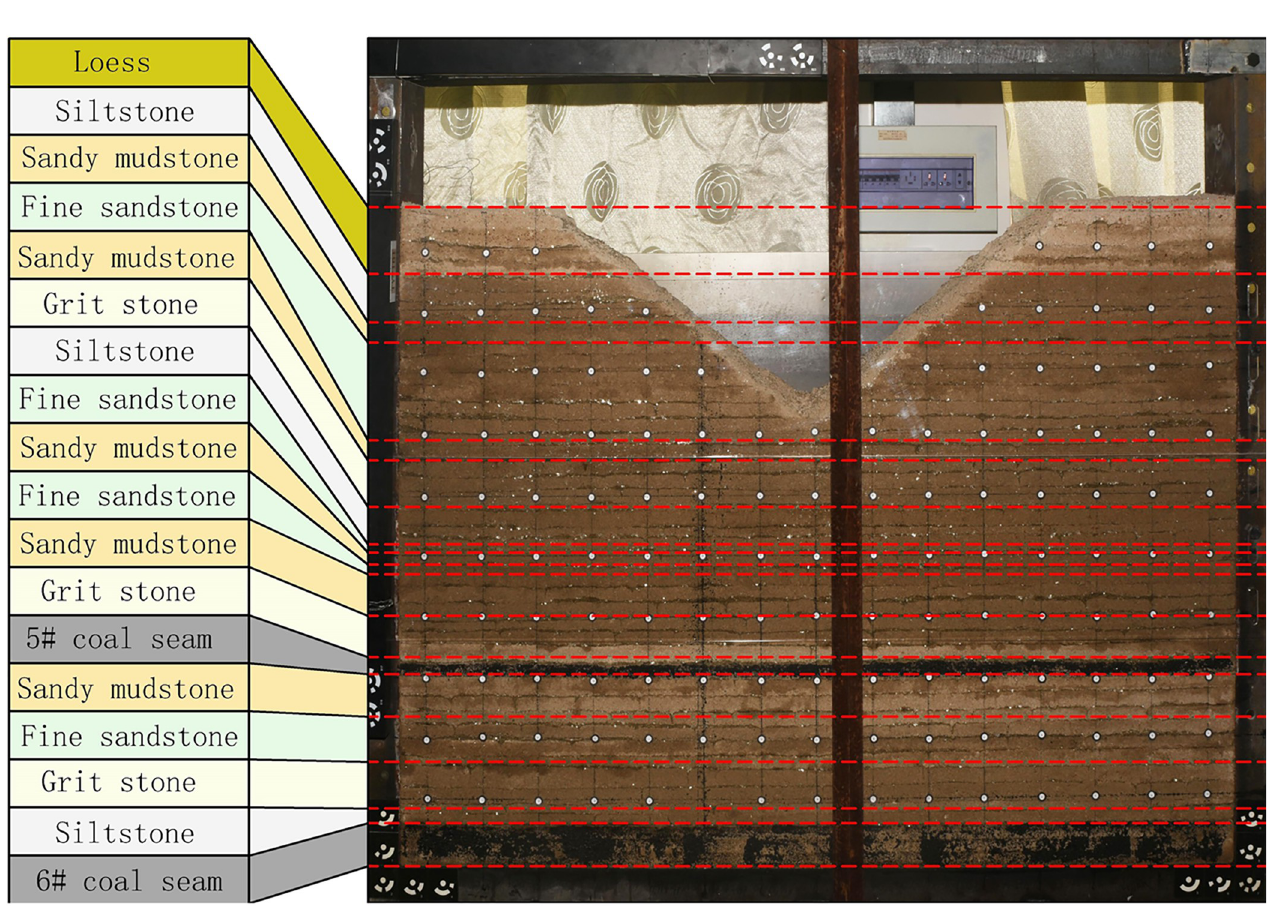
Fig 3. Physical similar simulation